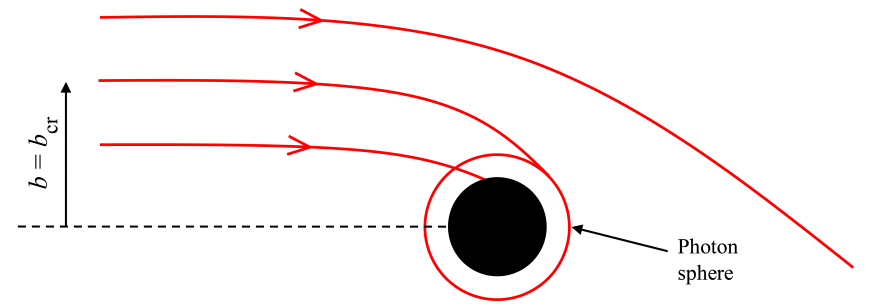
Figure 3. Schematic representation of trajectories of light rays incident from infinity toward a black hole with different impact parameters. Photons with b < b cr are absorbed by the black hole. The photons within b > b cr after approaching black hole flies off to infinity. Light rays with b = b cr are travelling to a photon sphere which contains unstable photon circular orbits. For the Schwarzschild space-time the Schwarzschild radius equals to 2 M , the photon sphere radius equals to 3 M , and critical √ √ impact parameter equals to b cr = 3 3 M . In case b (cid:29) 3 3 M , the photon deflection angle is small and can be calculated by approximate Einstein formula ˆ α = 4 M / b